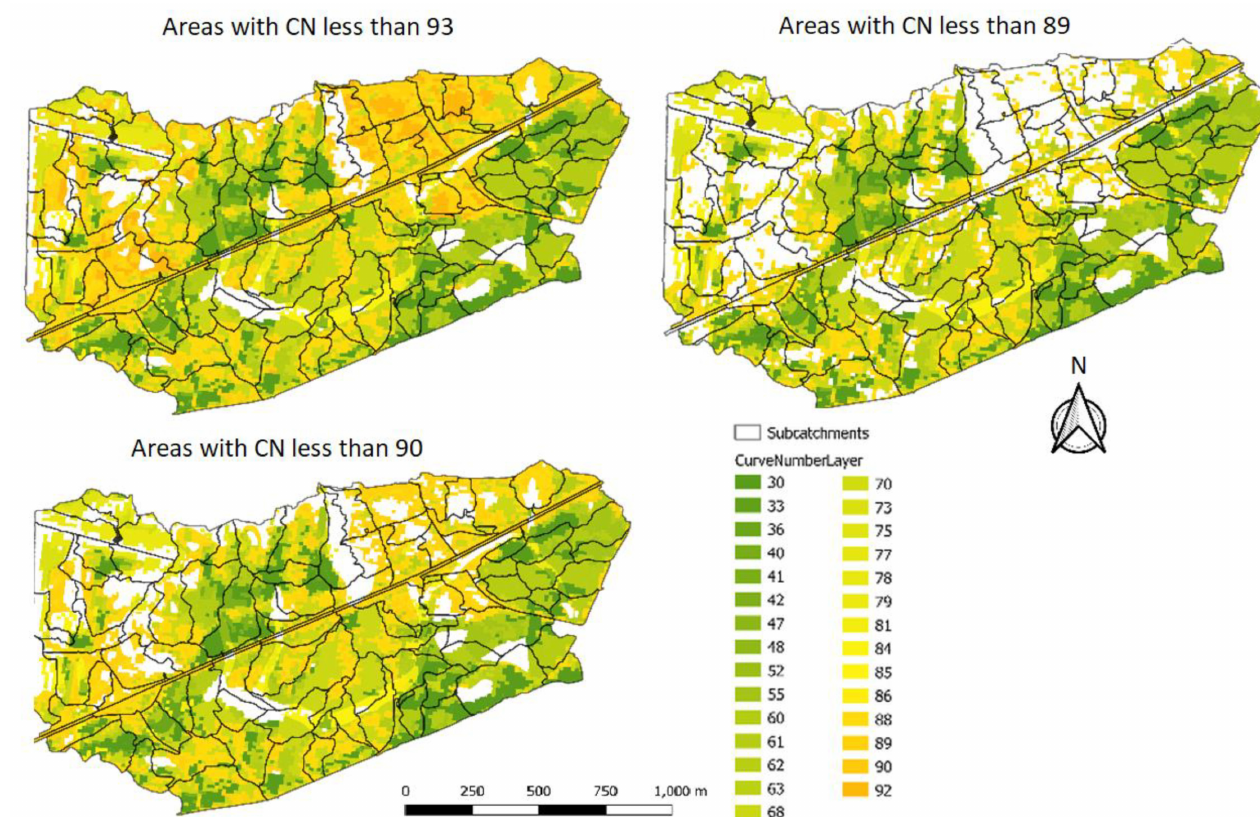
Figure 6. CN Cut-off maps for all thresholds. Notice the increase in white areas corresponding to impervious areas as the CN Cut-off value